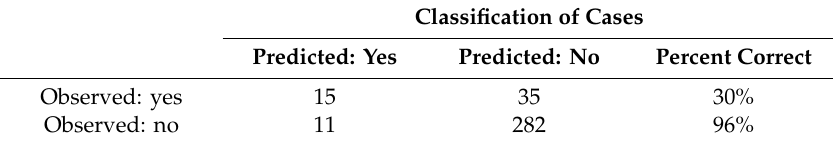
Table 6. Classification accuracy of the Logit model corresponding to the same cut-off as the ADD model.